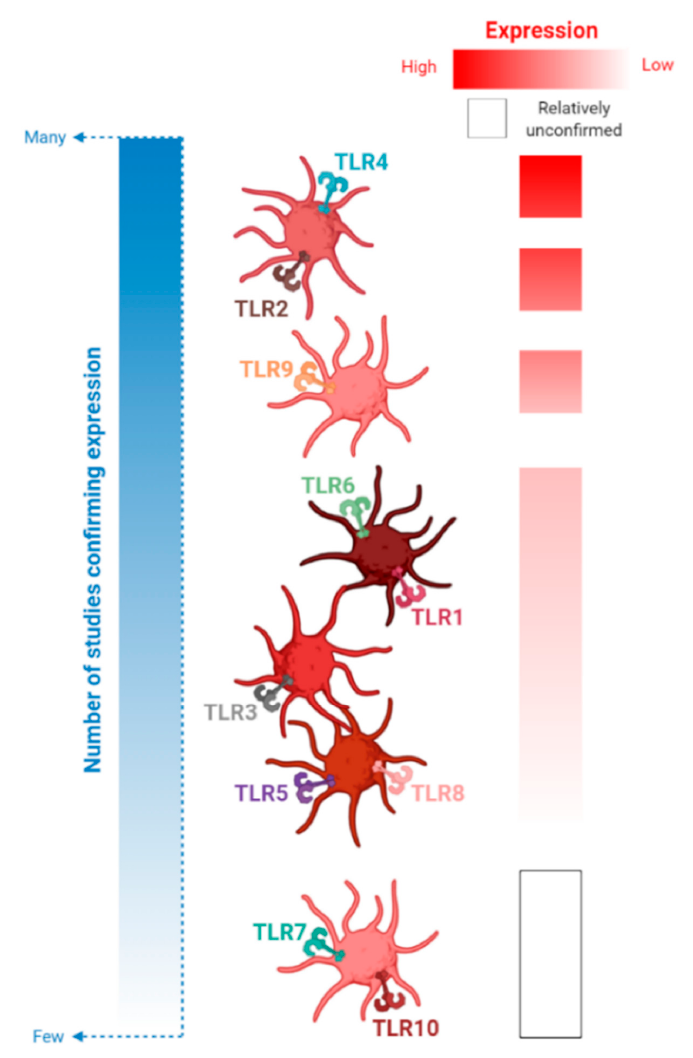
Figure 2. A summary of platelet ‐ TLR expression. All 10 TLRs have been identified on and within human platelets. In this figure, platelet ‐ TLRs are stratified by the number of studies that have measured expression levels (many vs. few), as indicated by the left ‐ hand blue panel. Platelet ‐ TLRs 2 and 4 are the most well ‐ studied while only a few papers investigate expression of platelet ‐ TLRs 7 and 10. The extent of expression on and within platelets is indicated by the right ‐ hand red panel. Most platelet ‐ TLRs (TLRs 1, 3, 5, 6 and 8) are expressed at low levels while others (TLRs 2, 4 and 9) are expressed more abundantly. Due to the low number of studies investigating TLRs 7 and 10, it is di ffi cult to determine the extent of their expression on / within